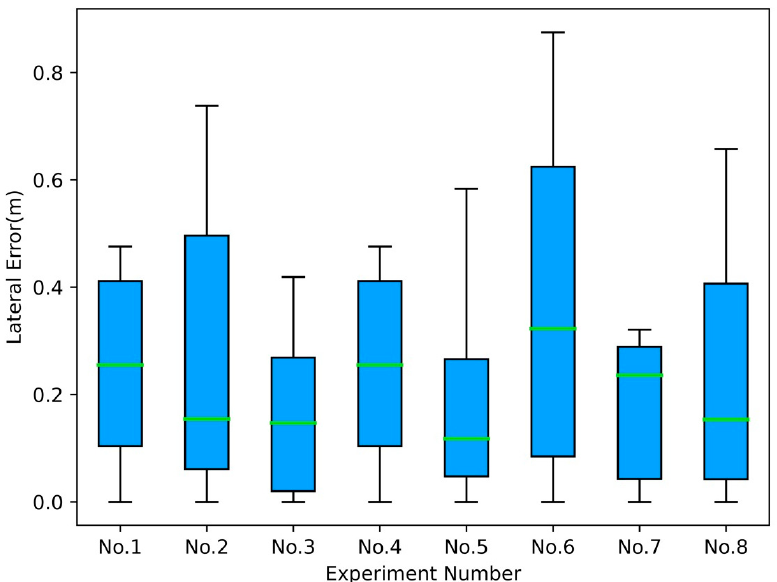
Figure 13. Field test performance of the row-following navigation system. The blue box is drawn from the median of the lower half of the dataset to the median of the upper half of the dataset with a horizontal green line drawn in the middle to denote the median.